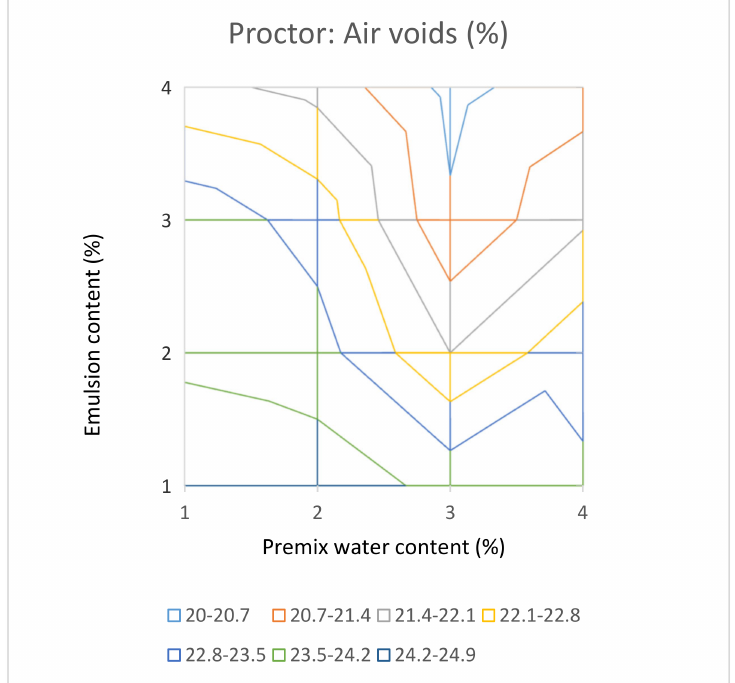
Figure 9. Air voids content for mixtures compacted with the modified Proctor